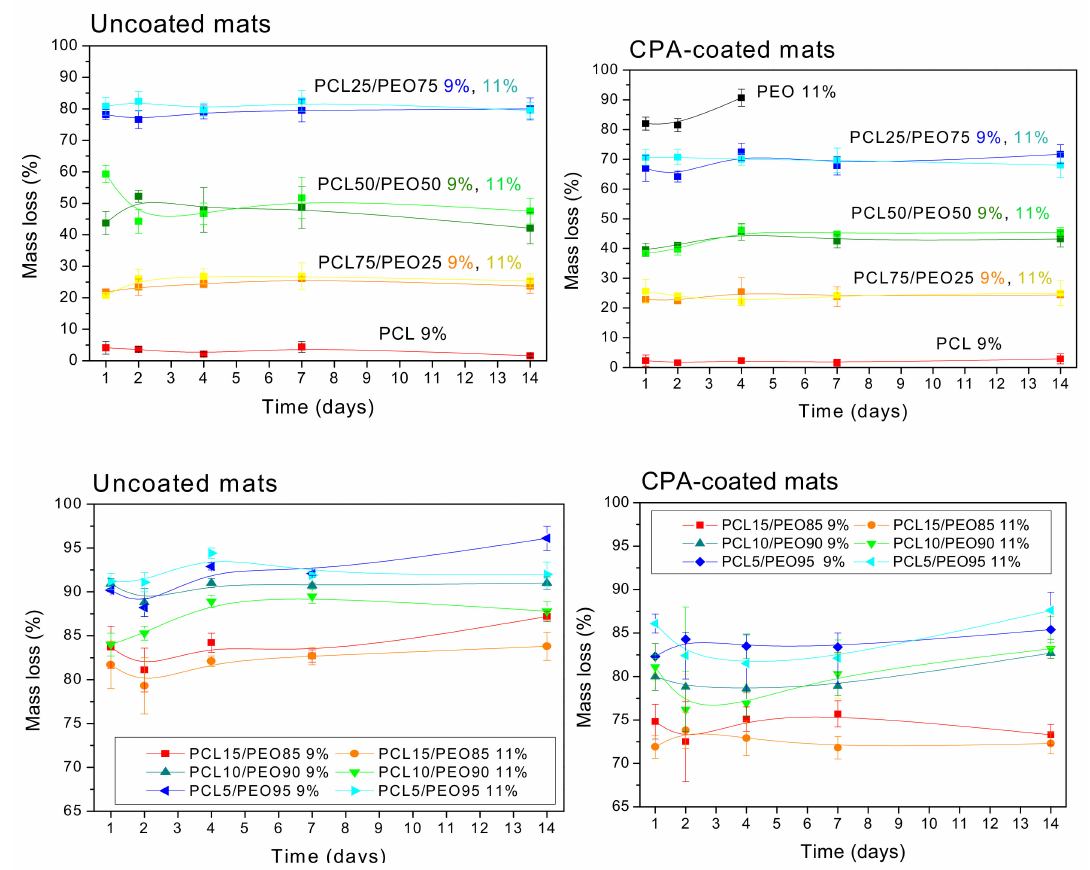
Figure 4. Hydrolytic degradation of the as-prepared (uncoated) and the CPA-coated nanofibrous mats in the period of 14 days. Top figures shows overview of changes with di ff erent PCL / PEO ratios and the bottom figures provide details in the PCL /